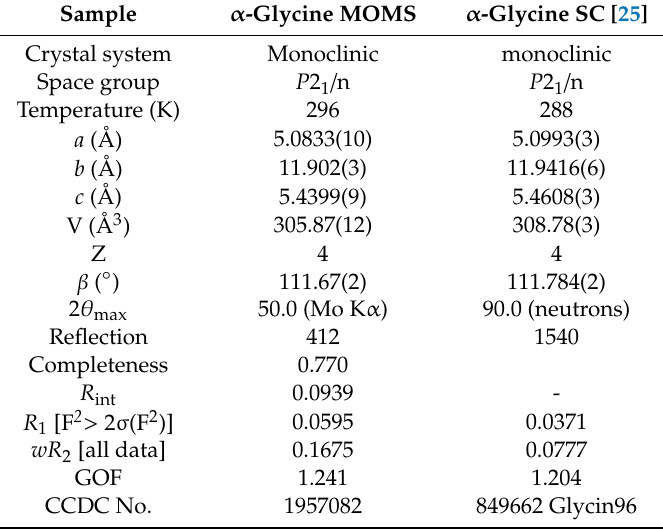
Table 1. Crystallographic data obtained from a three-dimensional (3D) MOMS and single crystal of α -glycine.